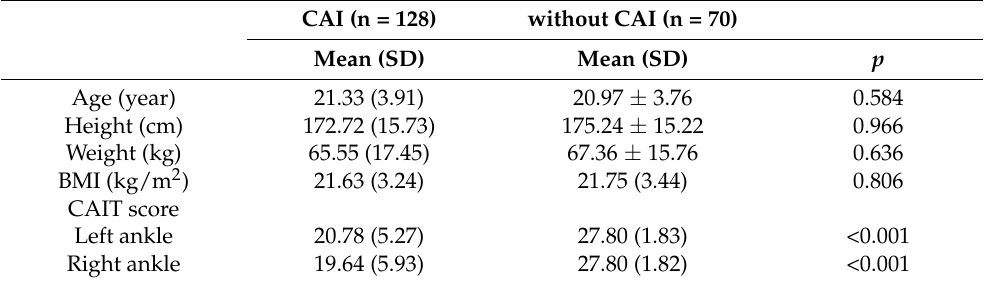
Table 2. History of ankle sprains and prevalence of CAI between genders. Female (n = 69) Male (n = 129) n (%) n (%) p Ankle sprain history Previous ankle sprain 62 (89.86) 108 (83.72)